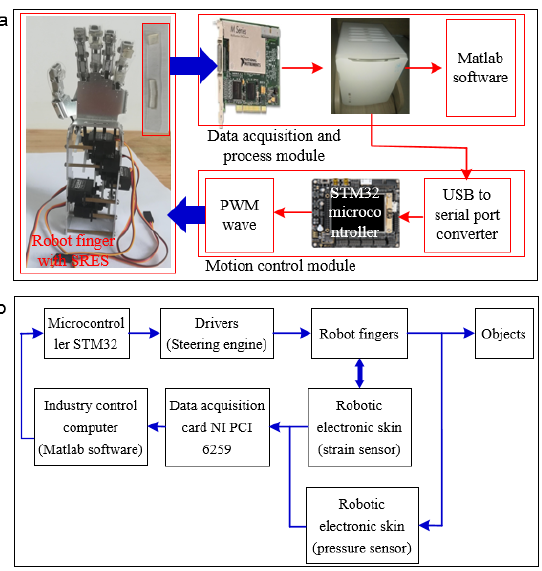
Figure 6. ( a ) Experiment platform of the robot finger with RES to grasp objects. ( b ) Signal flow of the grasping process of the robotic finger with negative force feedback by the capacitive pressure sensor.